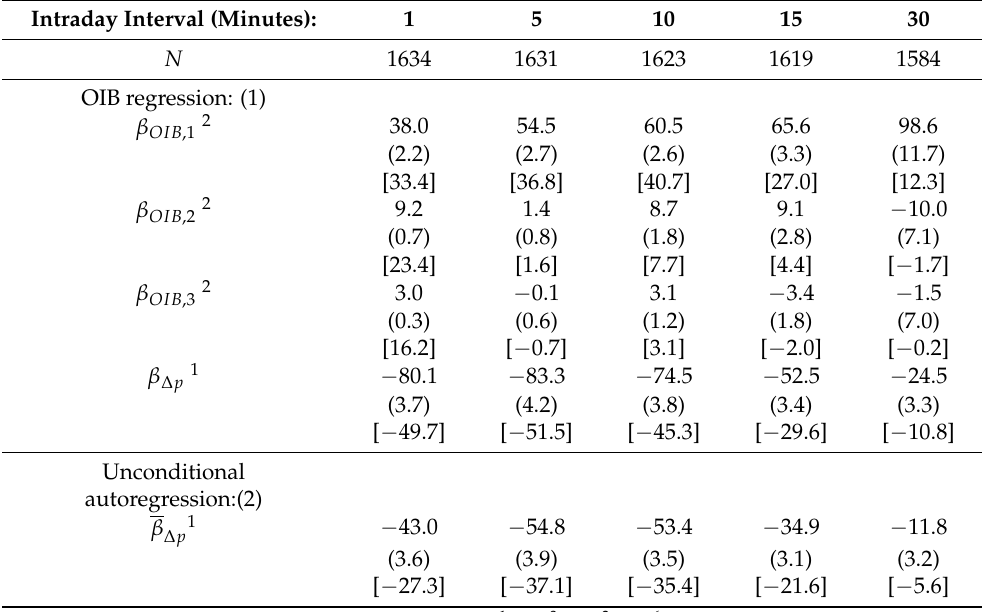
Table 4. Mean of coefficients of first step regressions (1) and (2). Robust standard errors are in brackets and t-statistics in square brackets. N is the number of regressions run and hence the number of first step coefficient